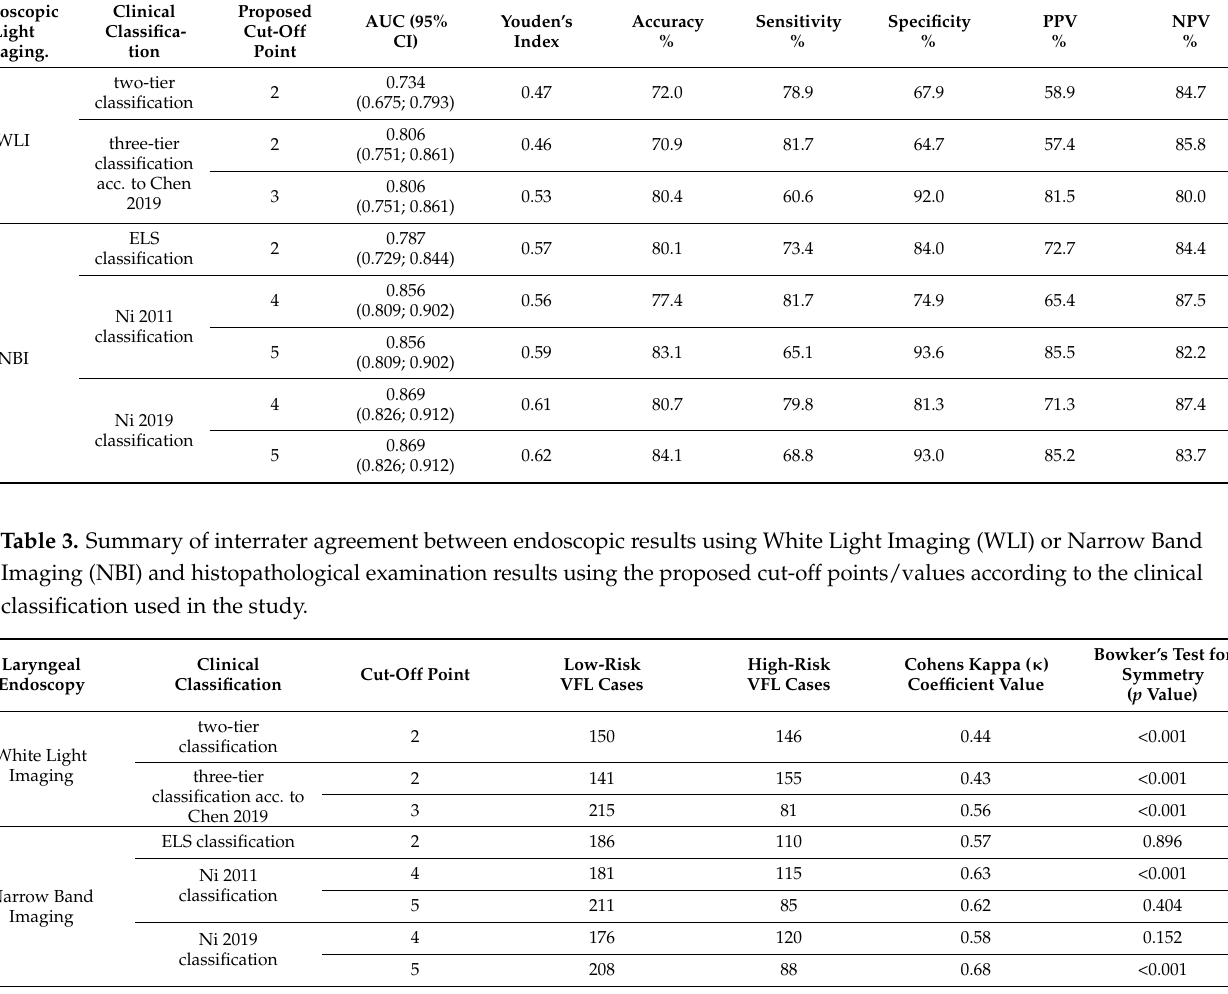
Table 2. Diagnostic performance of White Light Imaging (WLI) and Narrow Band Imaging (NBI) using different classifica- tions for the detection of high-risk leukoplakia. Endoscopic Light Imaging.